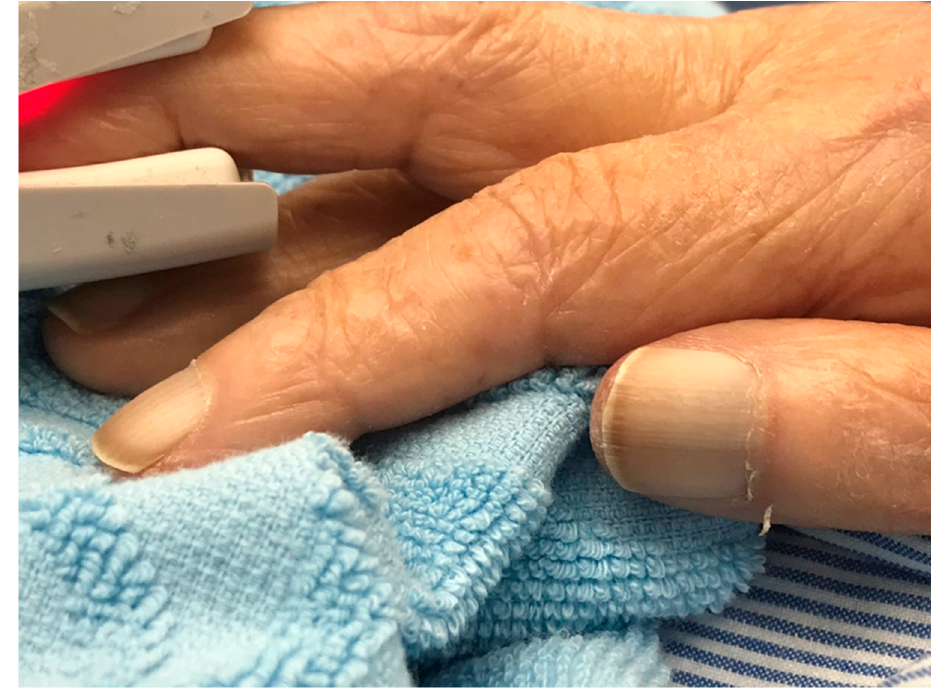
Figure 1. The patient’s white fingernail bed of the right hand.